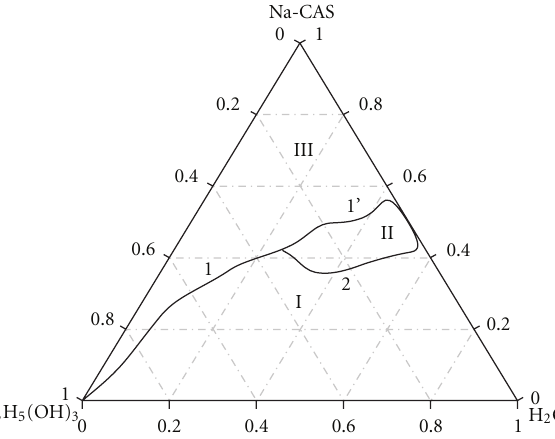
Figure 12: Solubility diagram of Na-CAS in water/glycerol at 18 ◦